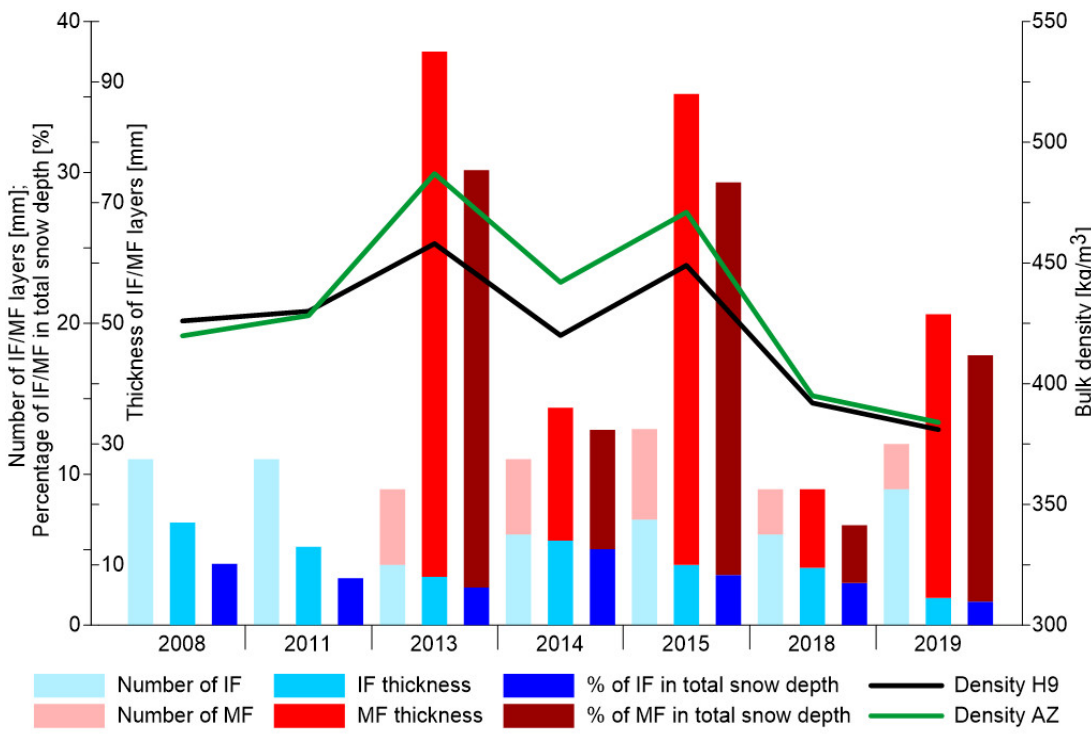
Figure 12. The number and thickness of Hard Layers (HL) (divided into Ice Formations and Melt Forms) vs. bulk density ( ρs ).